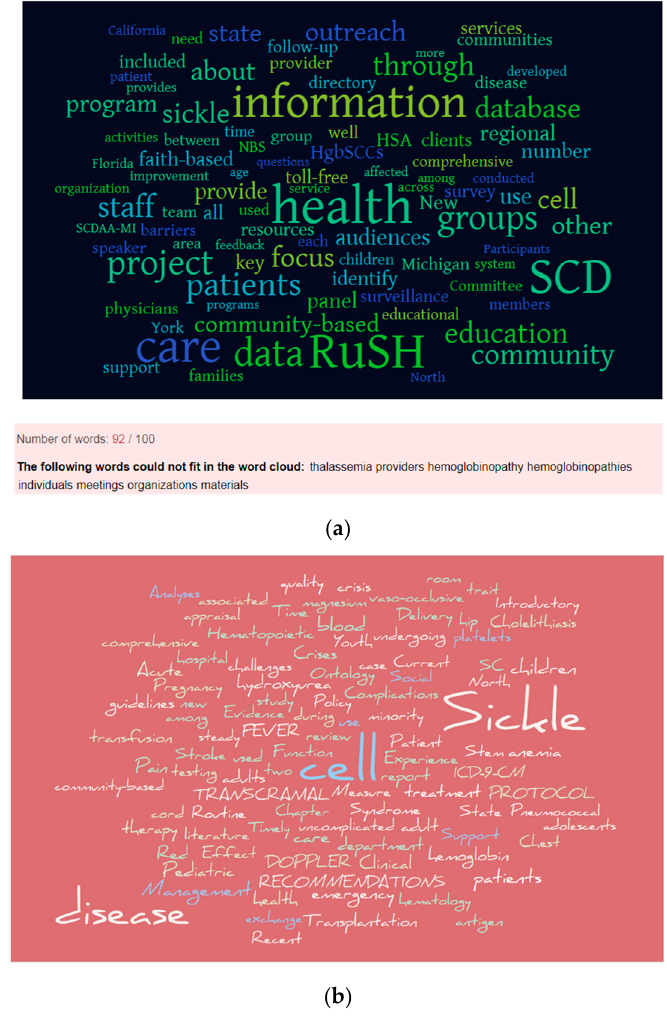
Figure 7. A comparison of word clouds generated from textual data on public health and clinical aspects of sickle cell disease. A common term to both aspects is “community-based”. ( a ) A word cloud of textual sentences from sections of the Registry and Surveillance System for Hemoglobinopathies (RuSH) report; ( b ) a word cloud of the titles of journal articles citing the National Heart, Lung and Blood Institute (NHLBI) Sickle Cell Disease Expert Panel report.